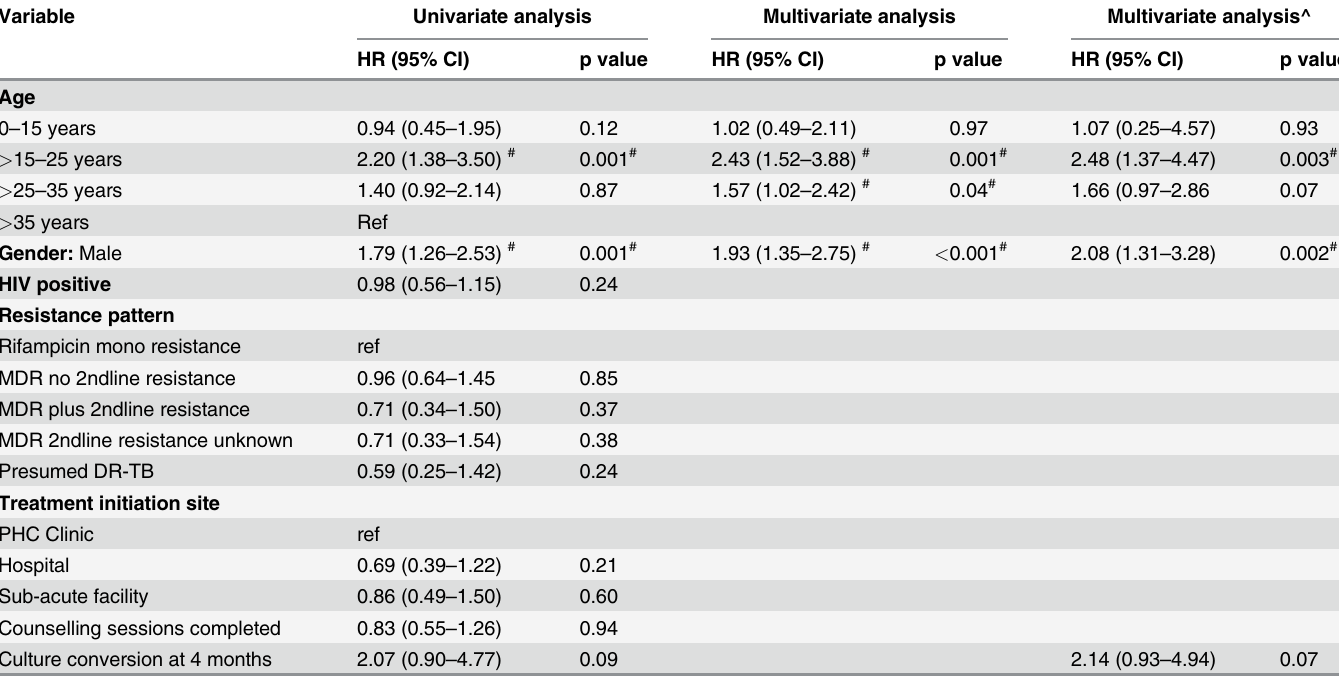
Table 2. Association of factors with time to loss from DR-TB treatment — 2009 – 2013 (n = 373 * ).